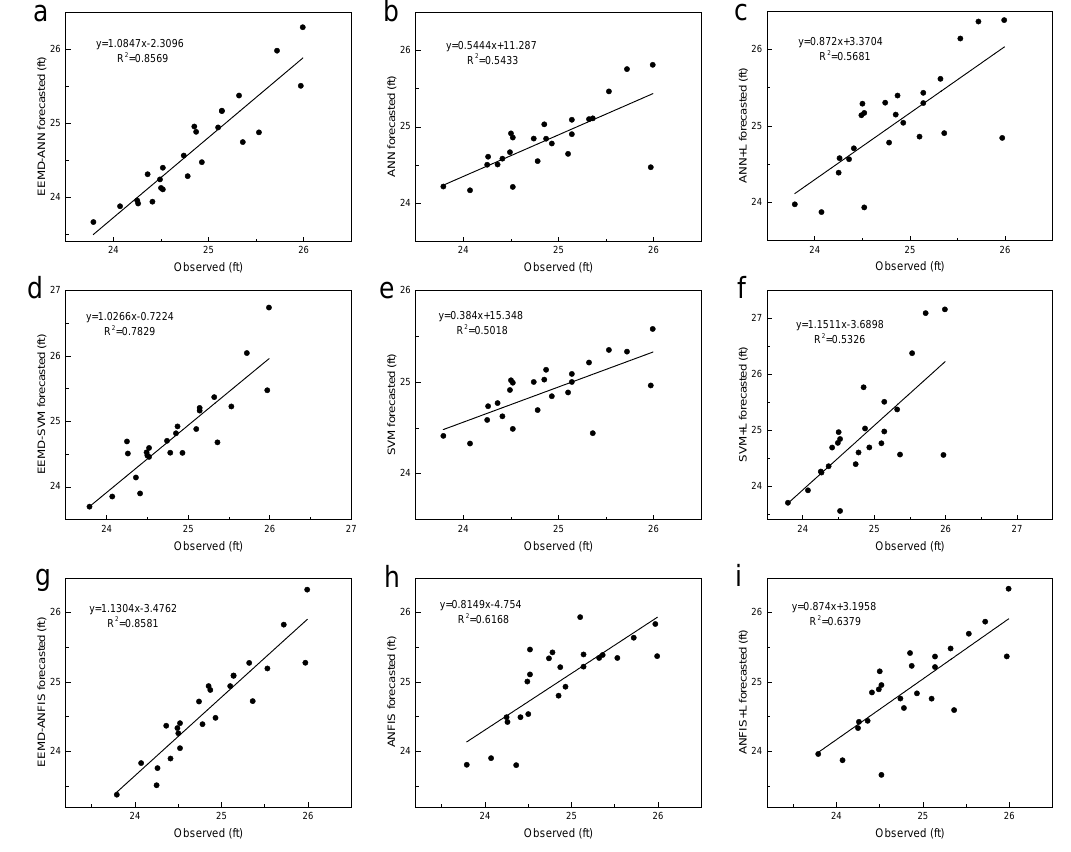
Figure 14. Observed and predicted groundwater levels at the M1255 observation well using ( a ) EEMD-ANN; ( b ) ANN; ( c ) ANN+L; ( d ) EEMD-SVM; ( e ) SVM; ( f ) SVM+L; ( g ) EEMD-ANFIS; ( h ) ANFIS; ( i ) ANFIS+L. ( x is observed groundwater level, y is predicted groundwater level).